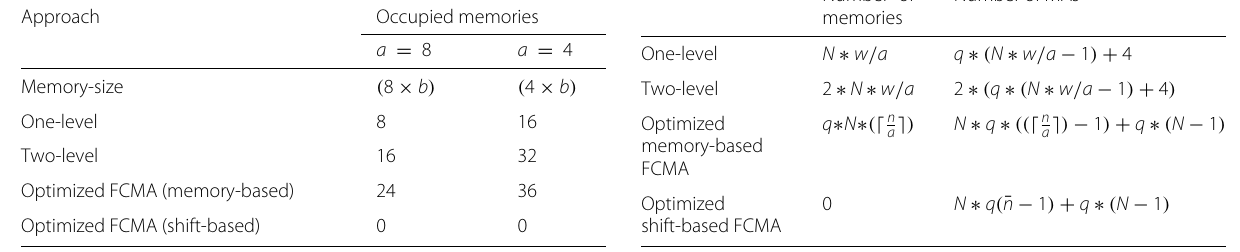
Table 2 Occupied memories that are used by RNS-based DB2 DWT approaches. The input word length, w , is 16 bits and b = 3 ∗ n + 1 Approach